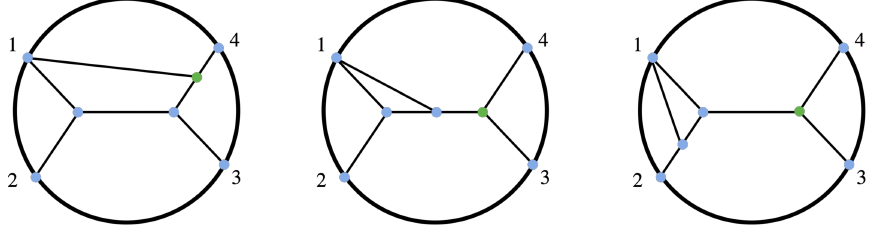
Figure 13 . Diagrams with one bound state and only cubic